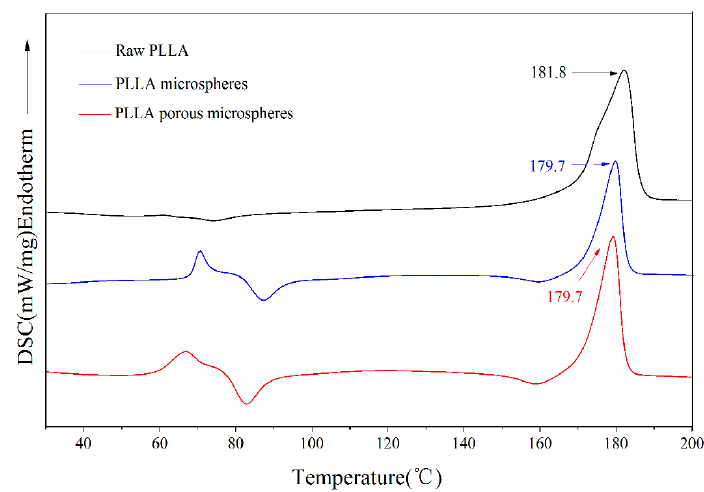
Figure 6. DSC curves of PLLA PMs.